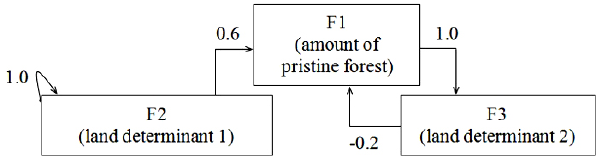
Fig. 1 . Graphical representation of a simple fuzzy cognitive map, indicating the factors (F1, F2, and F3), the causal relationship, and weights between factors. Based on Soler et al. 2012.